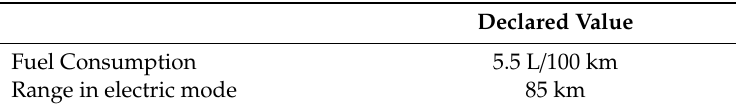
Table 28. Chevrolet Volt fuel consumption.